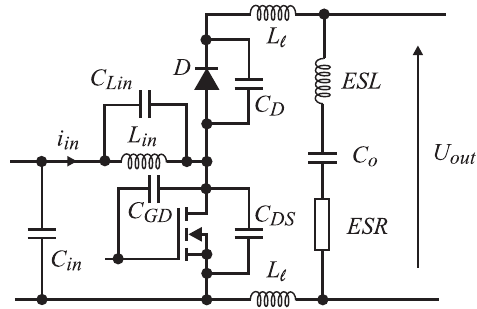
Figure 6. Parasitic elements in the boost converter.